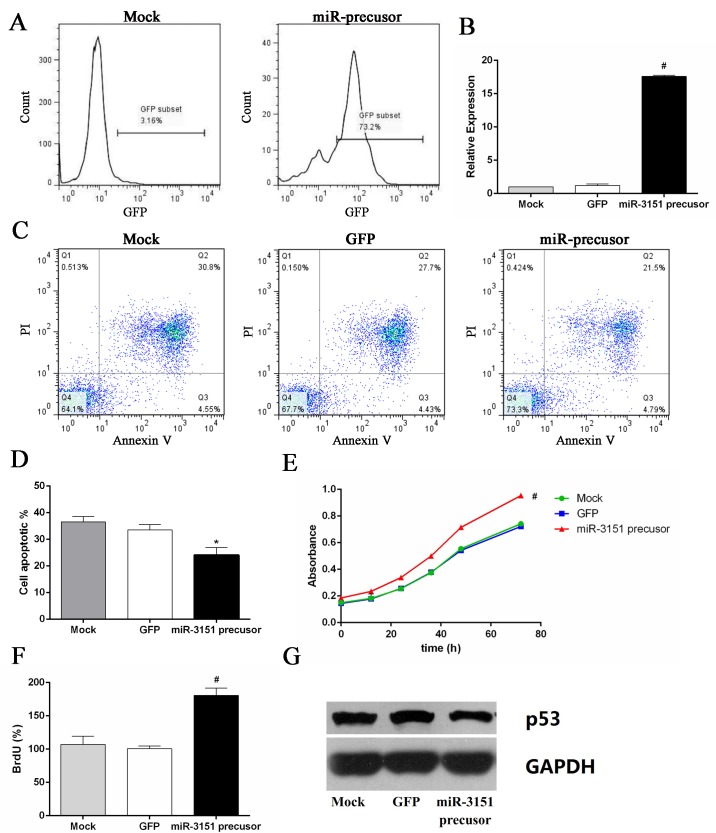
Overexpression of miR-3151 promoted cell proliferation and inhibition of p53 protein expression.(A) The positive rate of GFP in miR-3151 precusor group cells. (B) miR-3151 relative expression level after transfection. (C) Annexin V/PI double-staining flow cytometry of SKM-1 cells overexpressing miR-3151 treated with 46.20 nM HHT and 4.46 nM Bortezomib. (D) Overexpressing miR-3151 of SKM-1 cells partly reversed the effect of HHT and Bortezomib. (E) The cell viability of SKM-1 cells overexpressing miR-3151. (F) The cell proliferation of SKM-1 cells overexpressing miR-3151. (G) p53 protein level in SKM-1 cells overexpressing miR-3151. *P < 0.05, #P < 0.01 vs mock group.